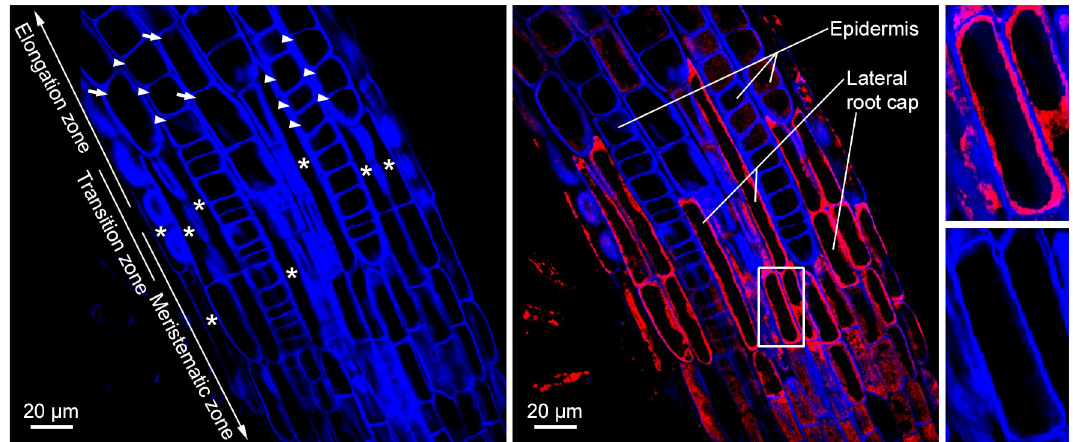
Fig 8. Pro-CEP2 accumulates within the protoplasm of the longer most cells from the upper end of the LR cap (PCD site I) at the level of the transition zone and is still present in root cap corpses. Roots of 7 days old WT seedlings expressing the pro- mCherry-CEP2 (P CEP2 ::pre-pro-3xHA-mCherry-AtCEP2-KDEL) are stained with calcofluor-white in order to visualize the cell wall and analyzed by CLSM (stack of 4 optical sections, Olympus Fluoview FV 1000). Left: Visualization of cell walls (blue): isodiametric, not elongated epidermis cells (arrow heads) from the meristematic and transition zone as well as already elongating epidermis cells (arrows) from the rapid elongation zone in addition to small, elongated and already collapsing cells at the upper end of the LRC (asterisk) are found. Middle: Merge of calcofluor (blue) and pro-mCherry-CEP2 (red): pro-CEP2 is found in the protoplasm of LR cap cells and is still present in root cap corpses sticking to epidermis cells of the rapid elongation zone. Pro-CEP is localized within the cell in the protoplasm surrounding the large vacuole and not in the cell wall. Right: magnification of the white boxed area presenting a LR cap cell with the blue coloured cell wall, the large black looking vacuole and in between the protoplasm with the red coloured pro-